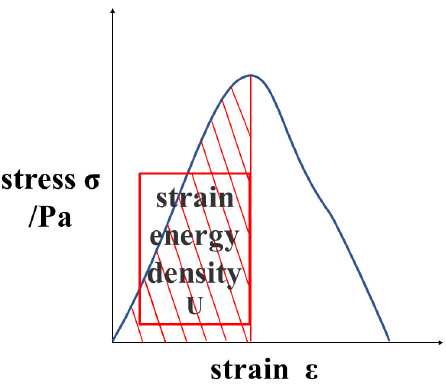
Figure 5. Bending strain energy.